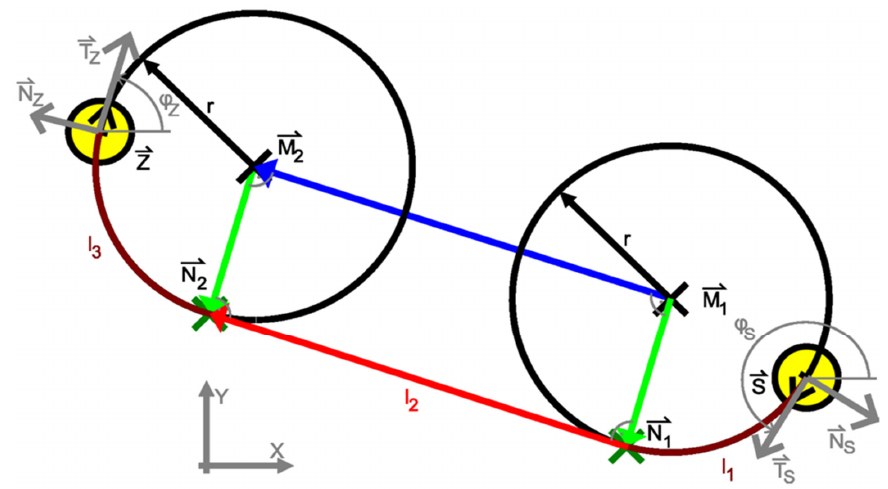
Figure 2. Sketch of the trajectory (clockwise).